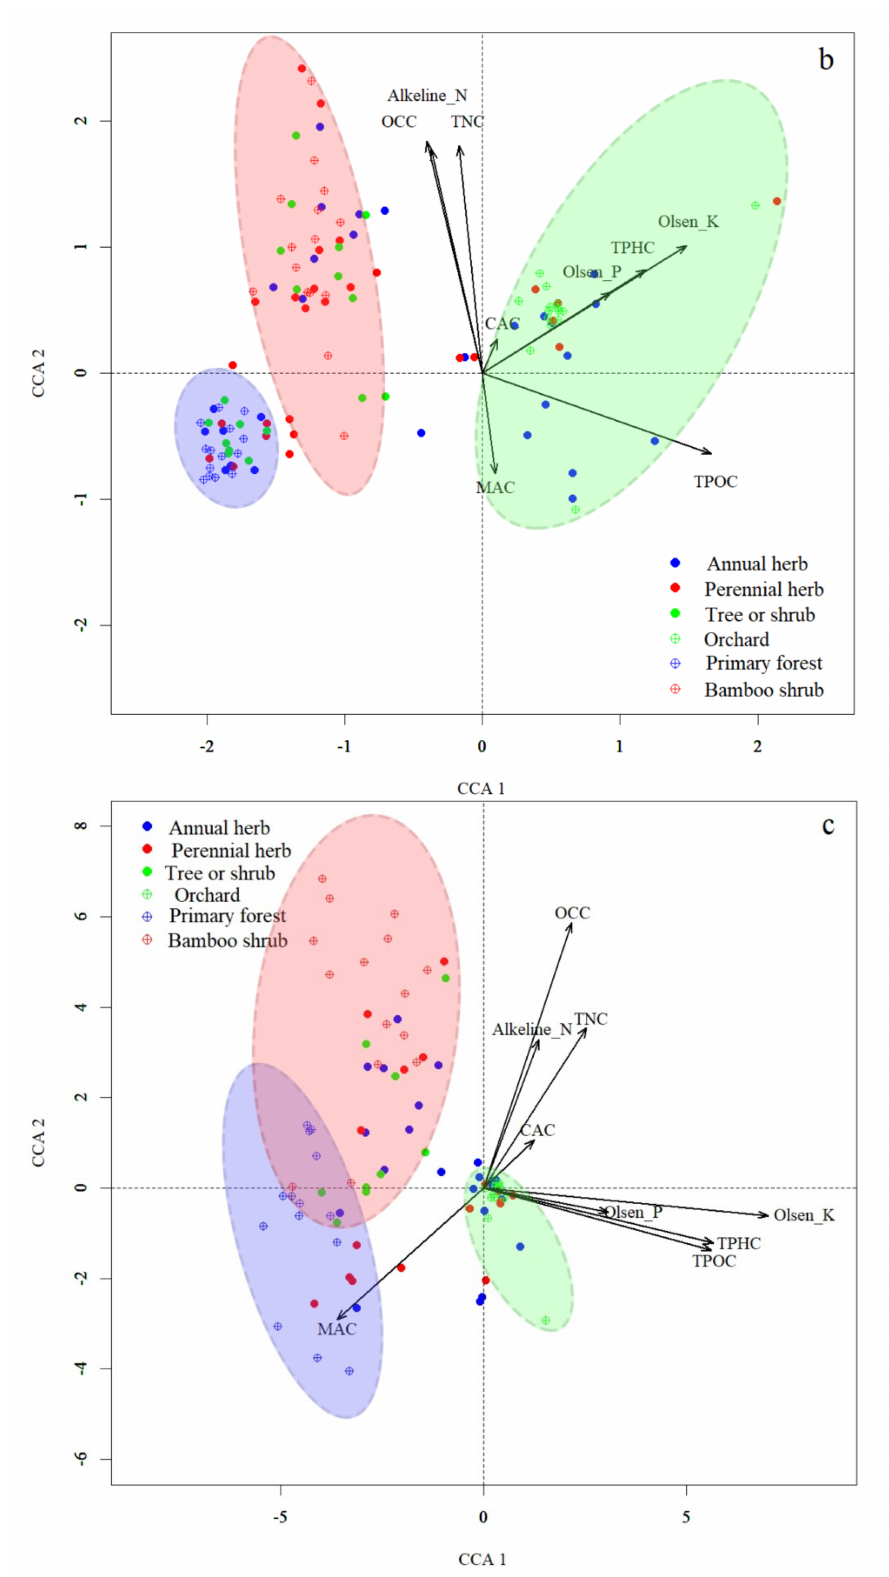
Figure 4. Principal component analysis (PCA, ( a )) and canonical correlation analysis (CCA, ( b , c )) of the correlation between aboveground vegetation, soil seed bank and soil chemical